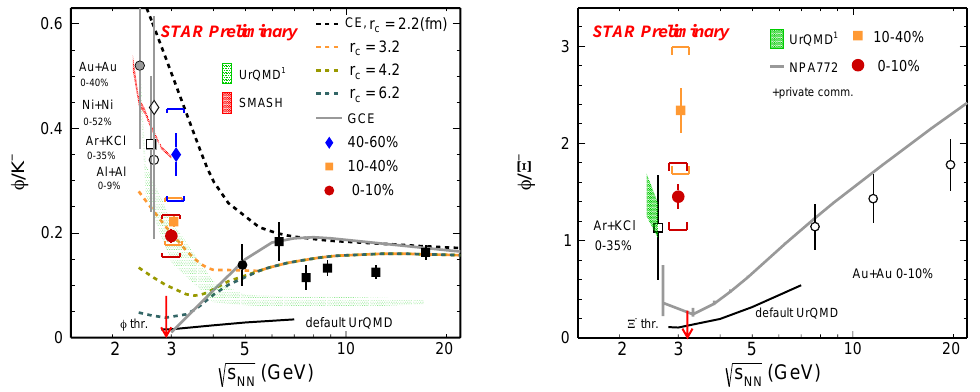
(cid:112) s . The solid color NN